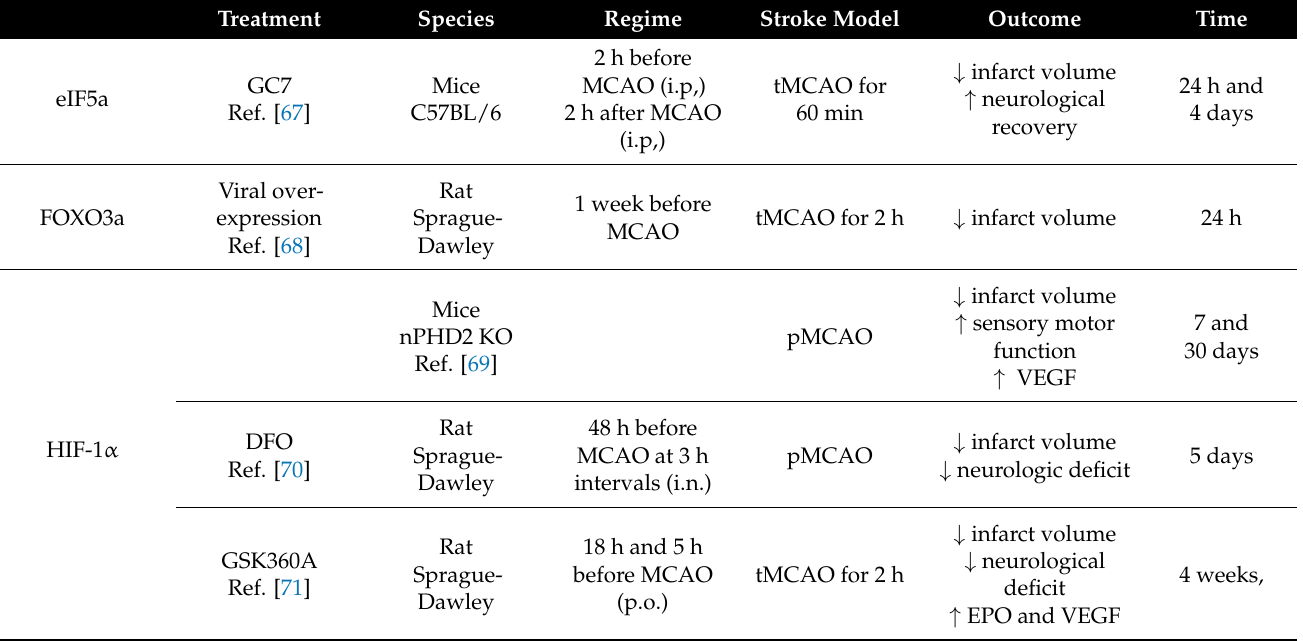
Table 2. Preclinical studies supporting the effectiveness of targeting the protective mechanisms described in tolerant species for the treatment of experimental stroke. Abbreviations: AR1: adenosine receptor 1: AR2: adenosine receptor 2; BBB: blood brain barrier; DFO: deferoxamine; EPO: erythropoietin; ET1: endothelin 1; i.c.v.: intracerebroventricular; i.p.: intraperitoneal; i.v.: intravenous; i.n.: intranasal; Ngb: neuroglobin; pMCAO: permanent middle cerebral artery occlusion; p.o.: per os (oral); s.c.: subcutaneous; tMCAO: transient middle cerebral artery occlusion; VEGF: Vascular Endothelial Growth Factor. ↓ : decrease; ↑